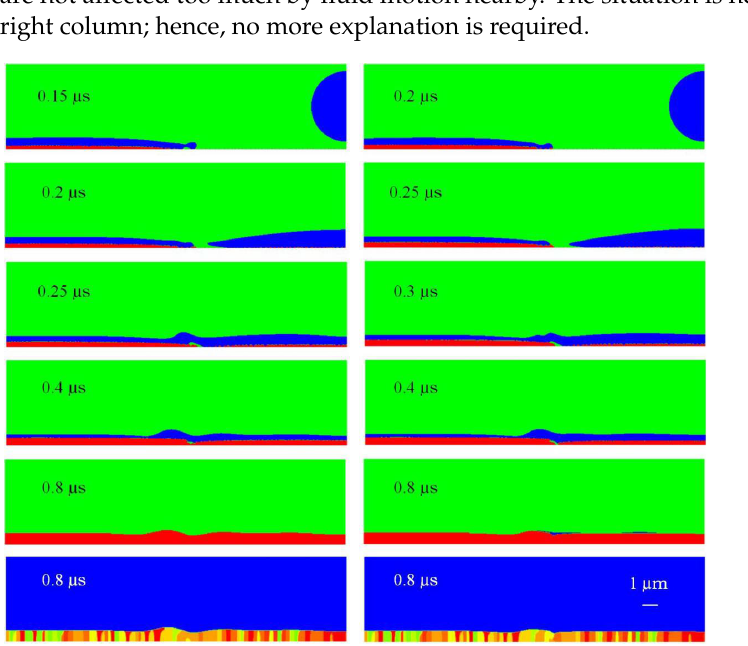
Figure 15. Effect of the set-in time of the second droplet.